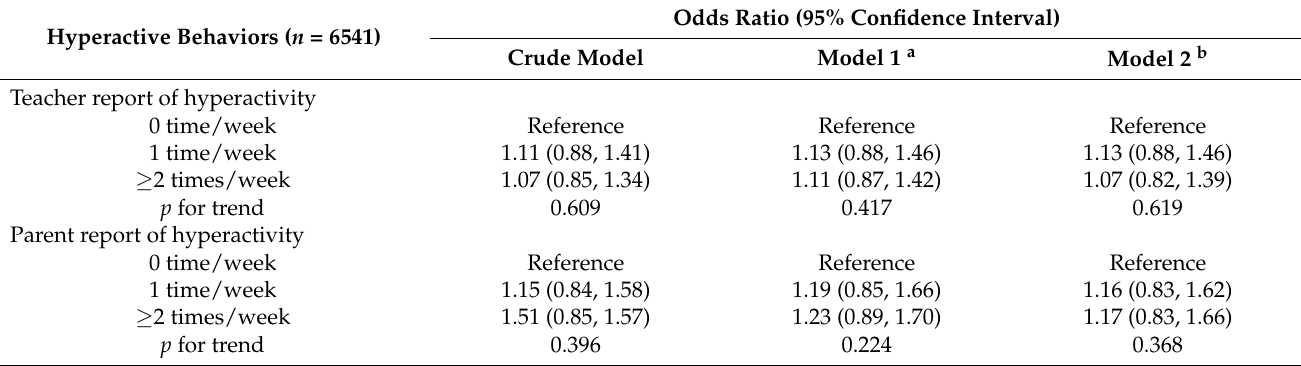
Table 3. Association between SSB intake with hyperactivity.